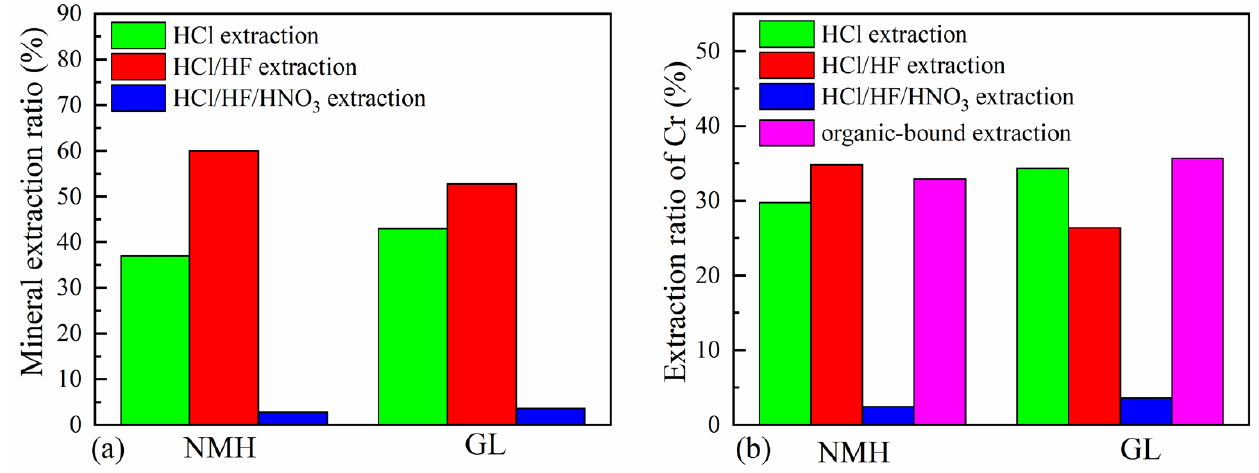
Figure 4. Extraction ratio of minerals and organic matter ( a ) and Cr ( b ) in NMH and GL